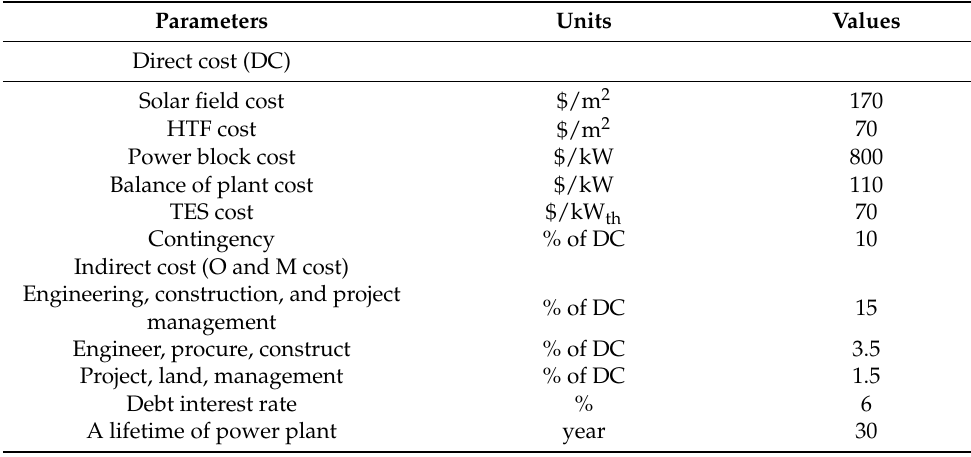
Table 2. Cost data for economic analysis of 50 MW CSP plant.